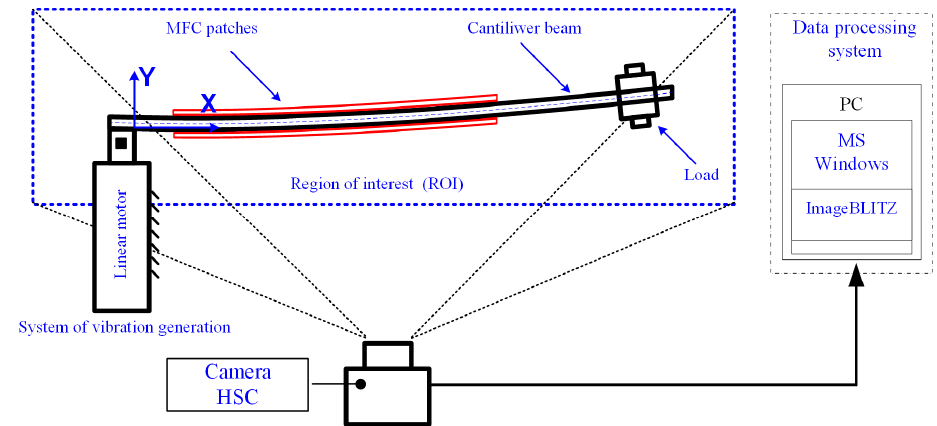
Figure 3. Schema of the vision system.